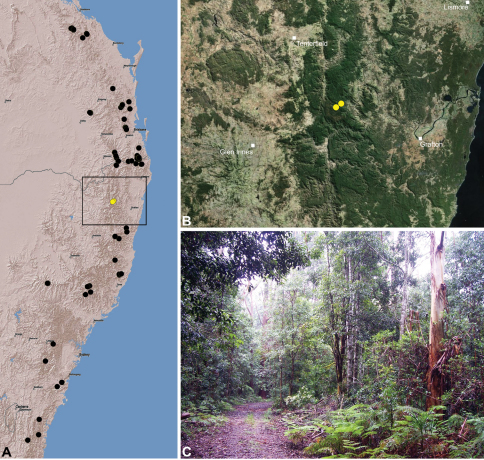
Austrarchaea monteithi sp. n., distribution and habitat: A, topographic map showing the known distribution of Archaeidae in south-eastern Queensland and eastern New South Wales, with collection localities for A. monteithi highlighted in yellow; B, satellite image showing detail of inset (A); C, subtropical rainforest at the type locality – near Richardsons Creek, Gibralter Range National Park, New South Wales (April 2010). Image (C) by M. Rix.